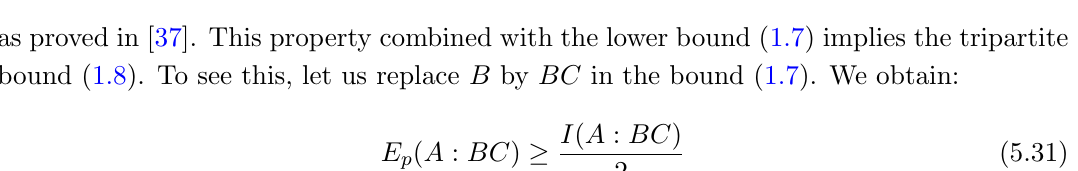
Figure 14. Graphical proof polygamy of E are used